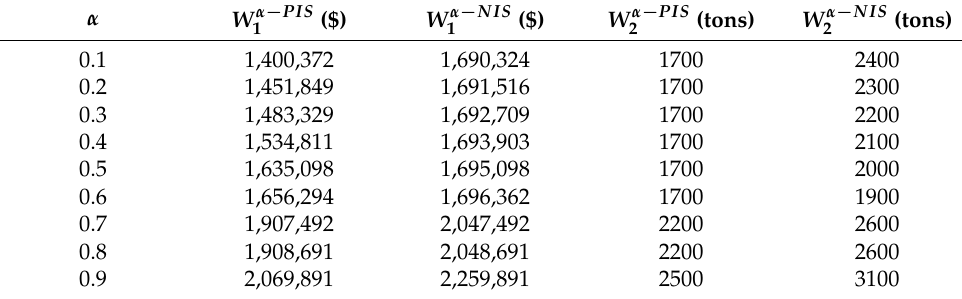
Table 1. Sensitivity analysis on degree of feasibility ( α